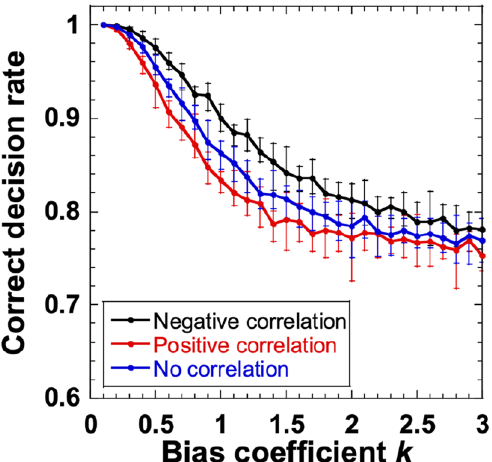
Figure 5. Correct decision rate (CDR) for two slot machines ( N = 2) assigned to temporal waveforms with negative (black), positive (red), and no (blue) correlations as the bias coefficient k increases. The cross bars represent the maximum and minimum values of the CDR for ten repetitions of the numerical